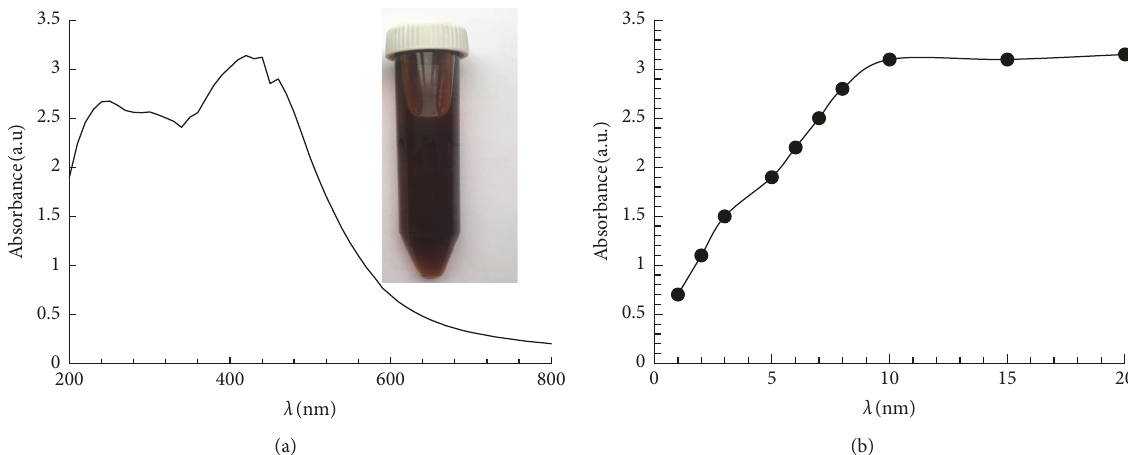
Figure 2: UV-Vis absorption spectrum of OrPWE-AgNPs after 10min of reaction displaying the characteristic surface plasmon resonance band at 430nm (a). The kinetic progression of the OrPWE-AgNPs reaction during 20min with the absorbance at 430nm (b).